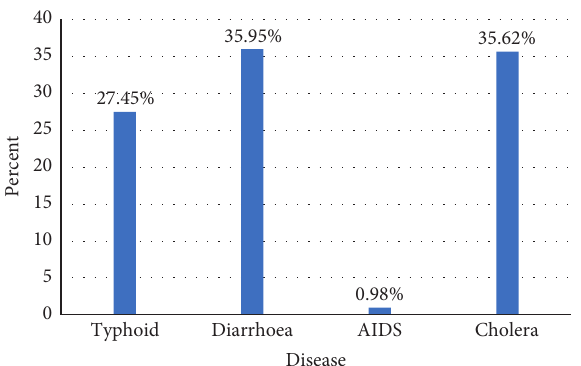
Figure 2: Diseases associated with improper handling of